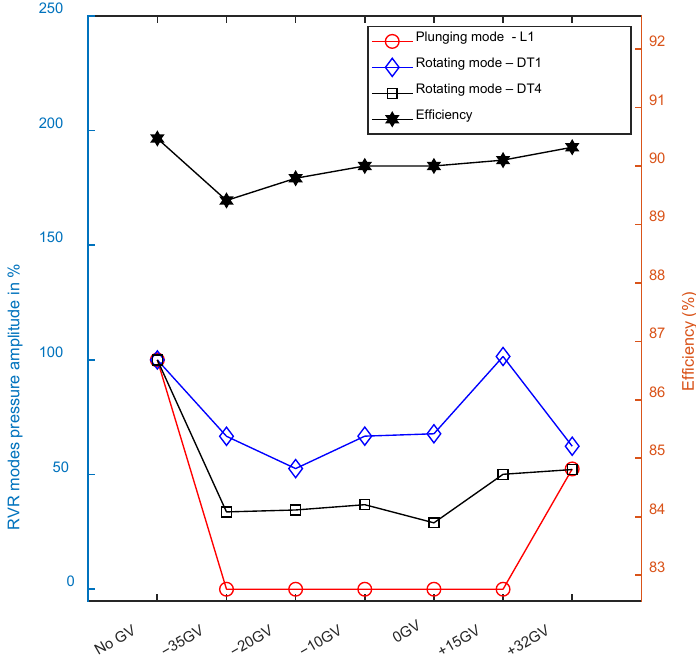
Figure 11. Hydraulic efficiency compared against decomposed RVR pressure amplitudes at PL2 without and with the GV systems at different upper hydrofoil angles.